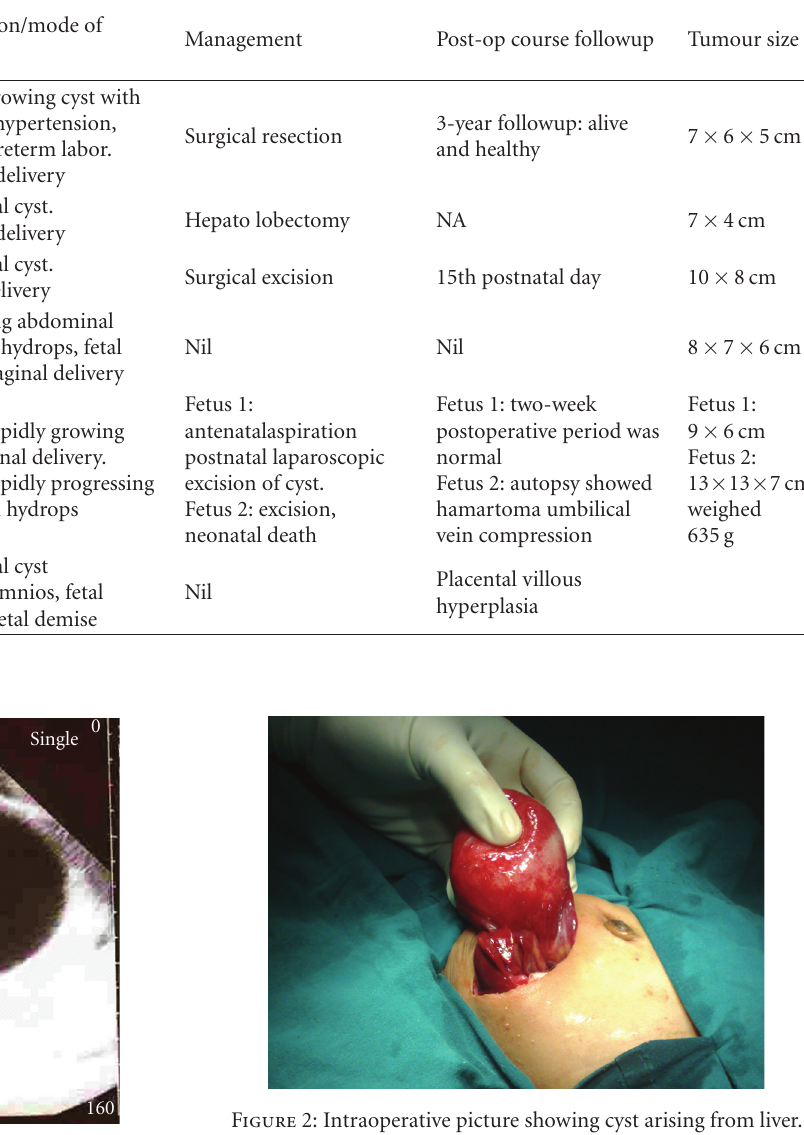
Figure 1: Prenatal ultrasound picture showing intra-abdominal cyst measuring 8 × 8cm.